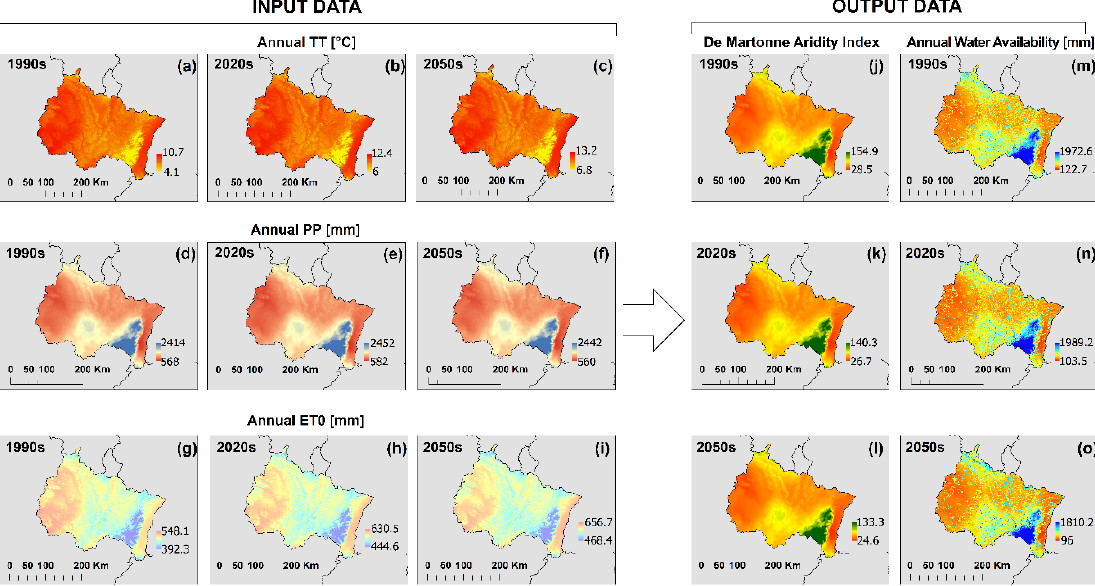
Figure 1. Climate variables as input data in the Grand Est region and output results. ( a ) Mean annual air temperature (TT) in 1990s. ( b ) Mean annual air temperature (TT) in 2020s. ( c ) Mean annual air temperature (TT) in 2050s. ( d ) Mean annual precipitation (PP) in 1990s. ( e ) Mean annual precipitation (PP) in 2020s. ( f ) Mean annual precipitation (PP) in 2050s. ( g ) Mean annual potential evapotranspiration (ET0) in 1990s. ( h ) Mean annual potential evapotranspiration (ET0) in 2020s. ( i ) Mean annual potential evapotranspiration (ET0) in 2050s. ( j ) De Martonne Aridity Index in 1990s. ( k ) De Martonne Aridity Index in 2020s. ( l ) De Martonne Aridity Index in 2050s. ( m ) Annual water availability in